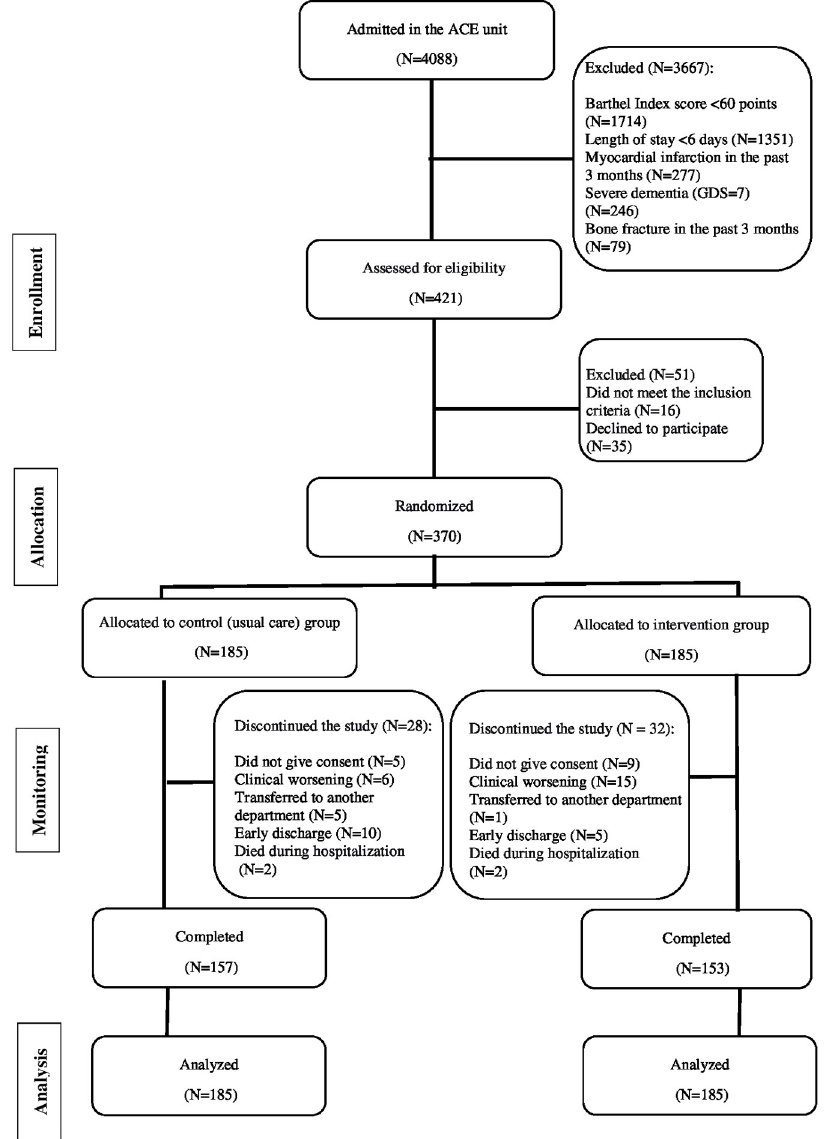
Fig 1. Study flow diagram. ACE, Acute Care of the Elderly; GDS, Yesavage Geriatric Depression Scale.